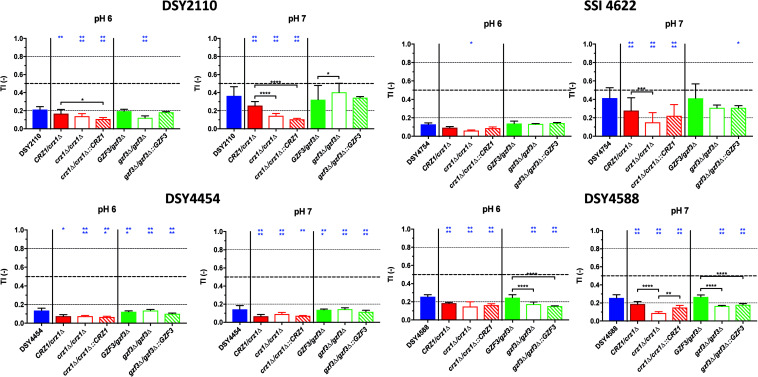
Tolerance levels of the different deletion mutants for both CRZ1 and GZF3 in the DSY2110, DSY4454, SSI 4622, and DSY4588 genetic backgrounds at pHs 6.0 and 7.0. Each bar corresponds to at least biological duplicates. Statistical significance was calculated using Turkey multiple comparison tests (95% confidence interval). P-values: 0.1234 (ns), ≤0.0332 (*), ≤0.0021 (**), ≤0.0002 (***), ≤0.0001 (****). Blue stars correspond to the comparison with the parental clinical isolates (blue bars). Black stars correspond to the comparisons between related mutant strains. Supplementary Table S1 lists correspondence between genotype and strain number.